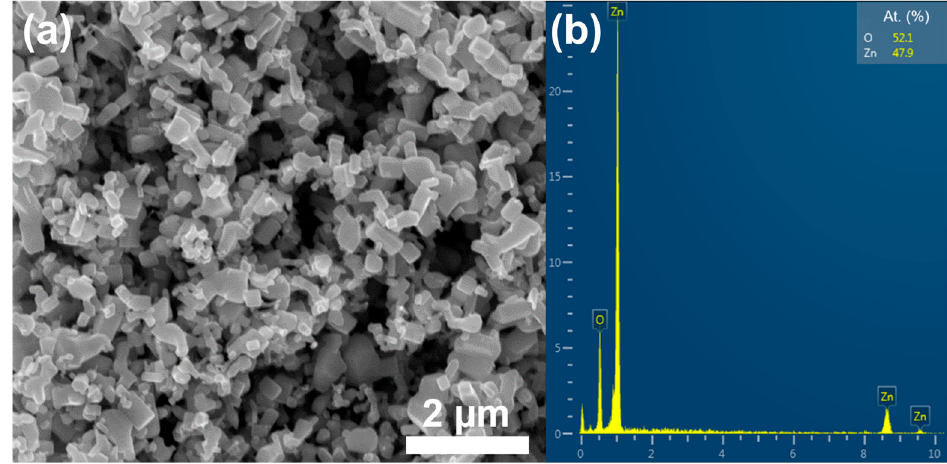
Figure 1. SEM image ( a ) and corresponding EDX spectrum ( b ) of commercial ZnO